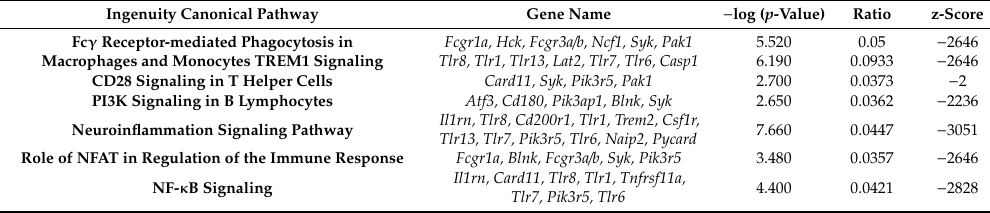
Abbreviations: Fc Fragment of IgG Receptor (Fcgr), Hemopoietic Cell Kinase (Hck), Neutrophil Cytosolic Factor (Ncf), Spleen Associated Tyrosine Kinase (Syk), P21 (RAC1) Activated Kinase 1 (Pak1), Toll like receptors (Tlr), Linker For Activation of T Cells Family Member 2 (Lat2), Caspase 1 (Casp1), Caspase Recruitment Domain Family Member 11 (Card11), Phosphoinositide-3-Kinase Adaptor Protein 1 (Pik3ap1), Phosphoinositide-3-Kinase Regulatory Subunit 5 (Pik3r5), Activating Transcription Factor 3 (Atf3), Cd180 molecule (Cd180), B Cell Linker (Blnk), Cell Surface Glycoprotein CD200 Receptor 1 (Cd200r1), Triggering Receptor Expressed On Myeloid Cells 2 (Trem2), Colony Stimulating Factor 1 Receptor (Csf1r), NLR family apoptosis inhibitory protein (Naip2), PYD and CARD Domain Containing (Pycard), Interleukin 1 Receptor Antagonist (Il1rn), Tumor Necrosis Factor Receptor Superfamily, Member 11a, NFKB Activator